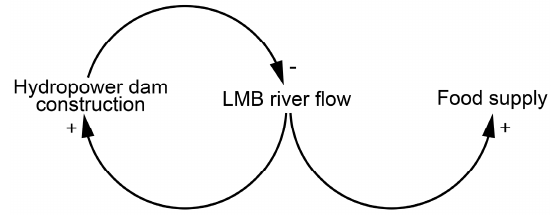
Figure 3. Model of resource uses of food supply and hydropower dam construction for energy generation using lower Mekong River Basin (LMB) river flow.